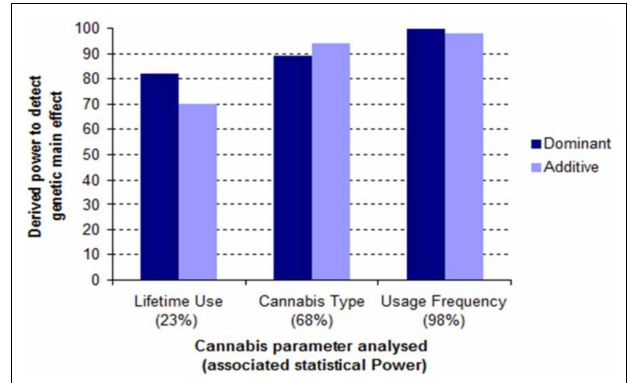
FIGURE 2 | Environmental vs. genetic power in the conditioned analyses of association with psychotic disorder . Life-time cannabis use, cannabis type, and frequency of cannabis use are associated with low (23%), intermediate (68%), and high (98%) statistical power (respectively) (Table S5 in Supplementary Materials).These power analyses confirm that conditioning on the more discriminating measures of cannabis use leads to larger genetic effects and, correspondingly, better detection efficiency (genetic power).The same pattern was also seen when these analyses were repeated under an additive genetic